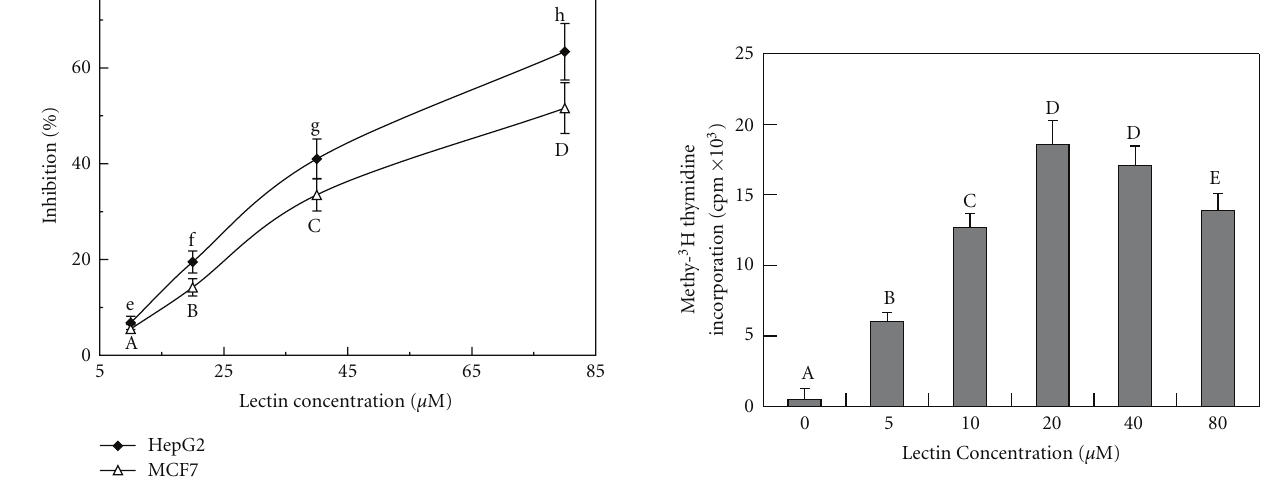
Figure 3: Inhibitory e ff ect of HEA on proliferation of Hep G2 and MCF-7 cancer cells line in vitro. Results represent mean ± SD ( n = 3). The IC 50 values toward HepG2 cells and MCF7 cells are 56.1 μ M and 76.5 μ M, respectively. Di ff erent alphabets next to the data points indicate statistically significant di ff erence ( P < . 05) when the data are analyzed by analysis of variance followed by Duncan’s multiple range test.